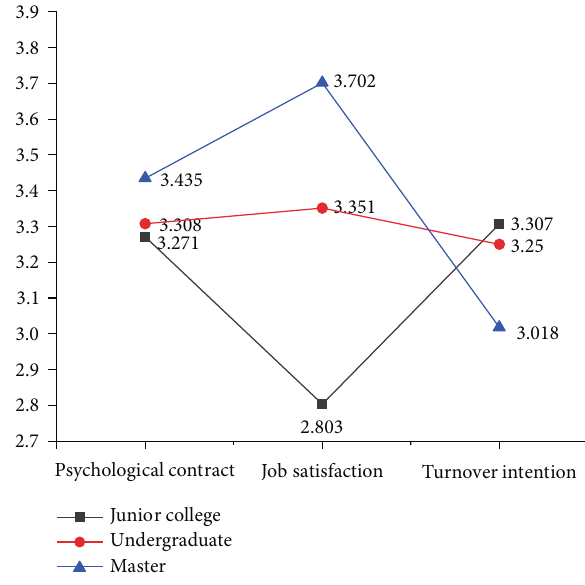
Figure 6: Comparison of mean values of variables with di ff erent